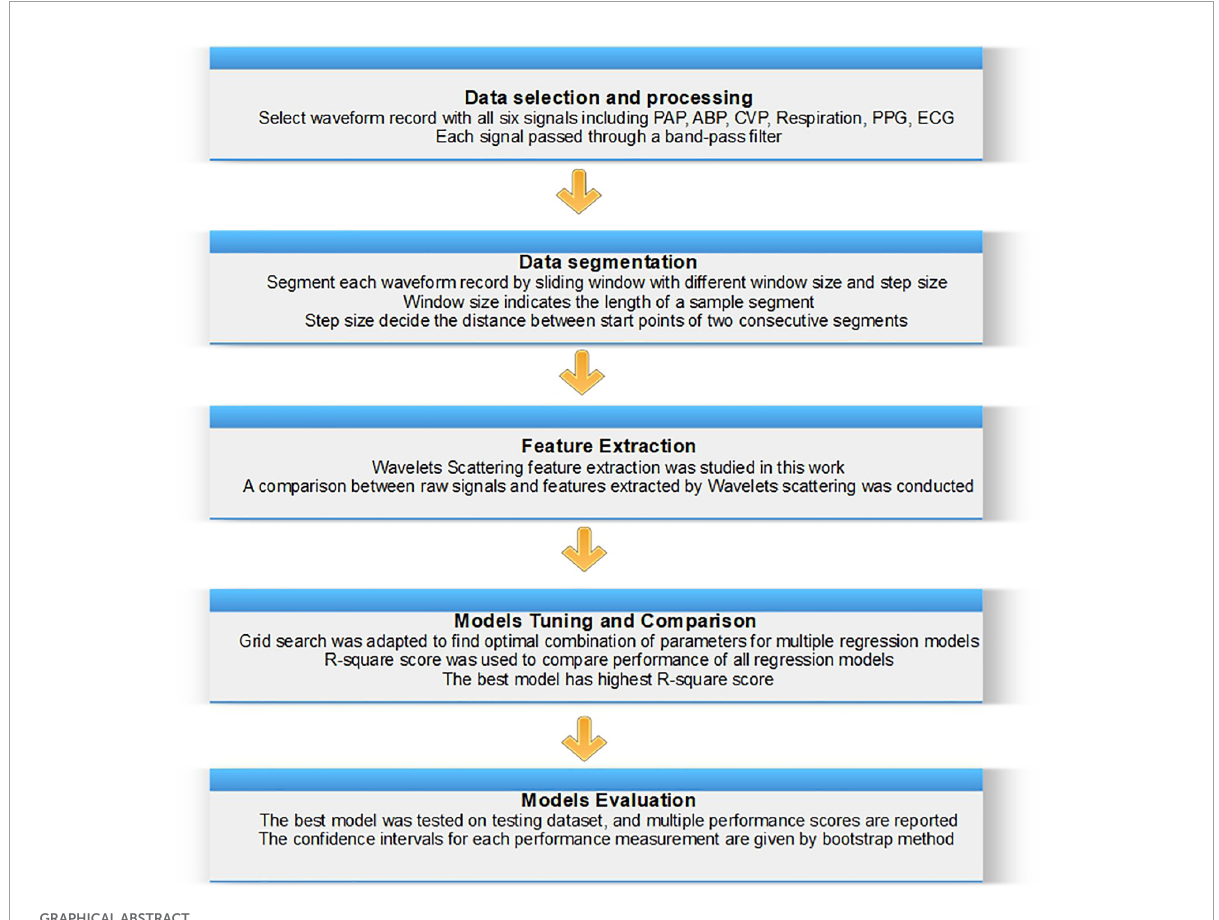
GRAPHICALABSTRACT Central illustration figure.